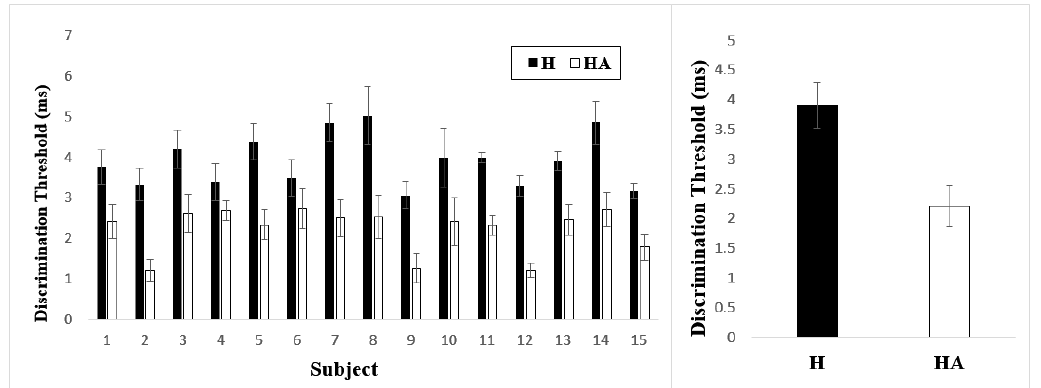
Figure 5. Discrimination thresholds (temporal sensitivity) estimated on tactile key click e ff ects on tablet touchscreens: thresholds estimated per participant (left) and the average thresholds (right) for the haptics alone (H) and haptics with audible sound (HA)